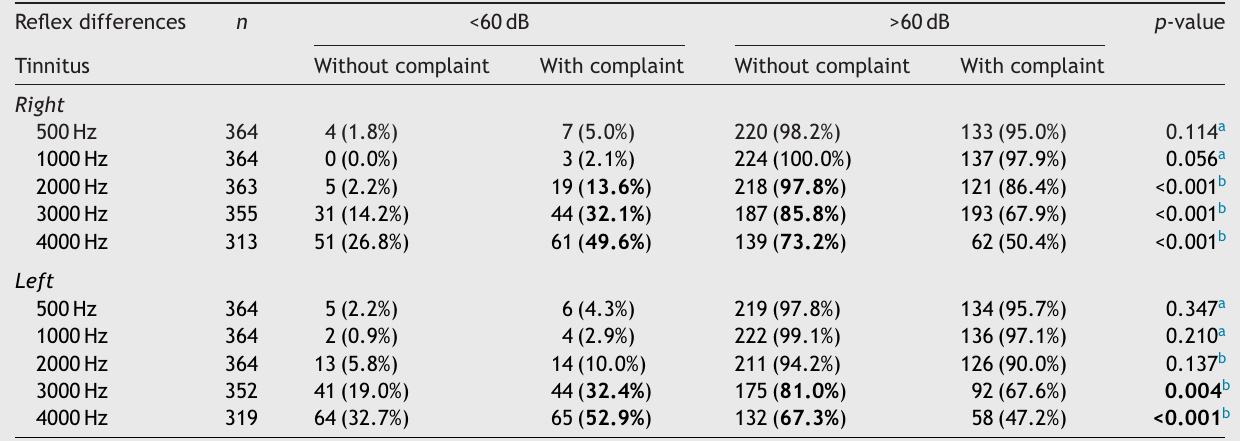
Comparison between lateral tinnitus and occurrence of Metz recruitment ( n = 364). Reflex differences